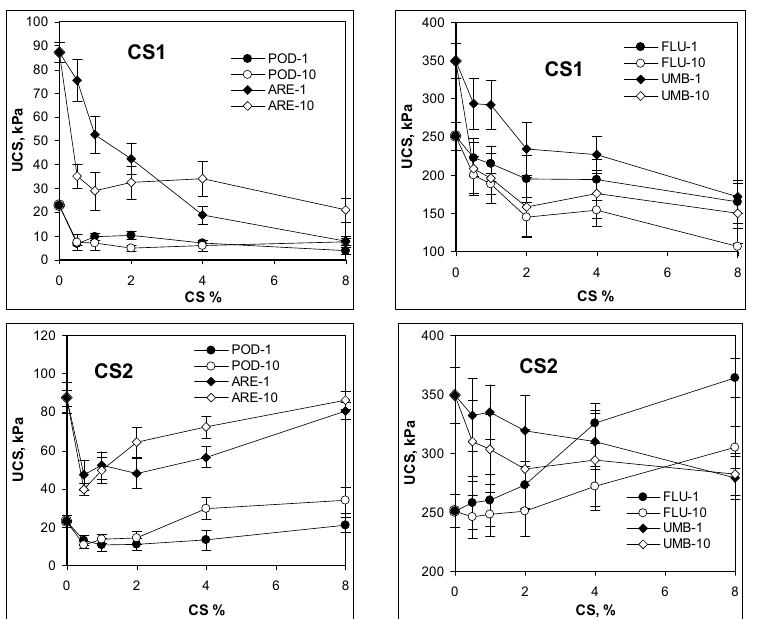
Figure 3. Average values of unconfined compressive strength of the studied aggregates of Podzol (POD), Fluvisol (FLU), Umbrisol (UMB) and Arenosol (ARE) amended with different amounts of chitosan (CS1 and CS2), preconditioned with one or ten cycles of wetting–drying. The number of the cycles is written after the abbreviation of soils. Error bars depict standard deviations.